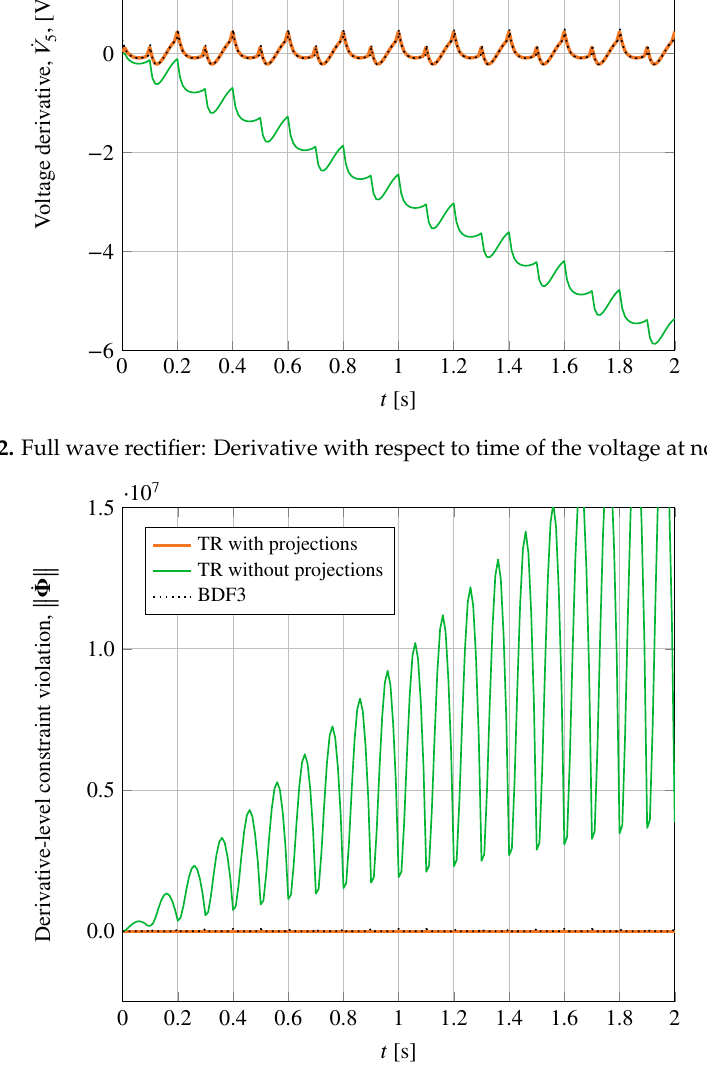
Figure 13. Full wave rectifier: Norm of derivative-level constraint violations term,